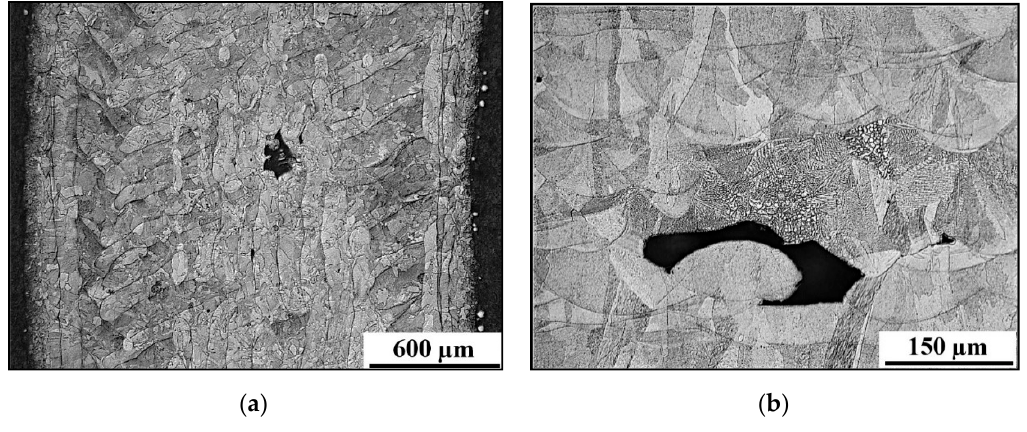
Figure 9. ( a ) Microstructure of the base metal; ( b ) Microstructure with process defects.